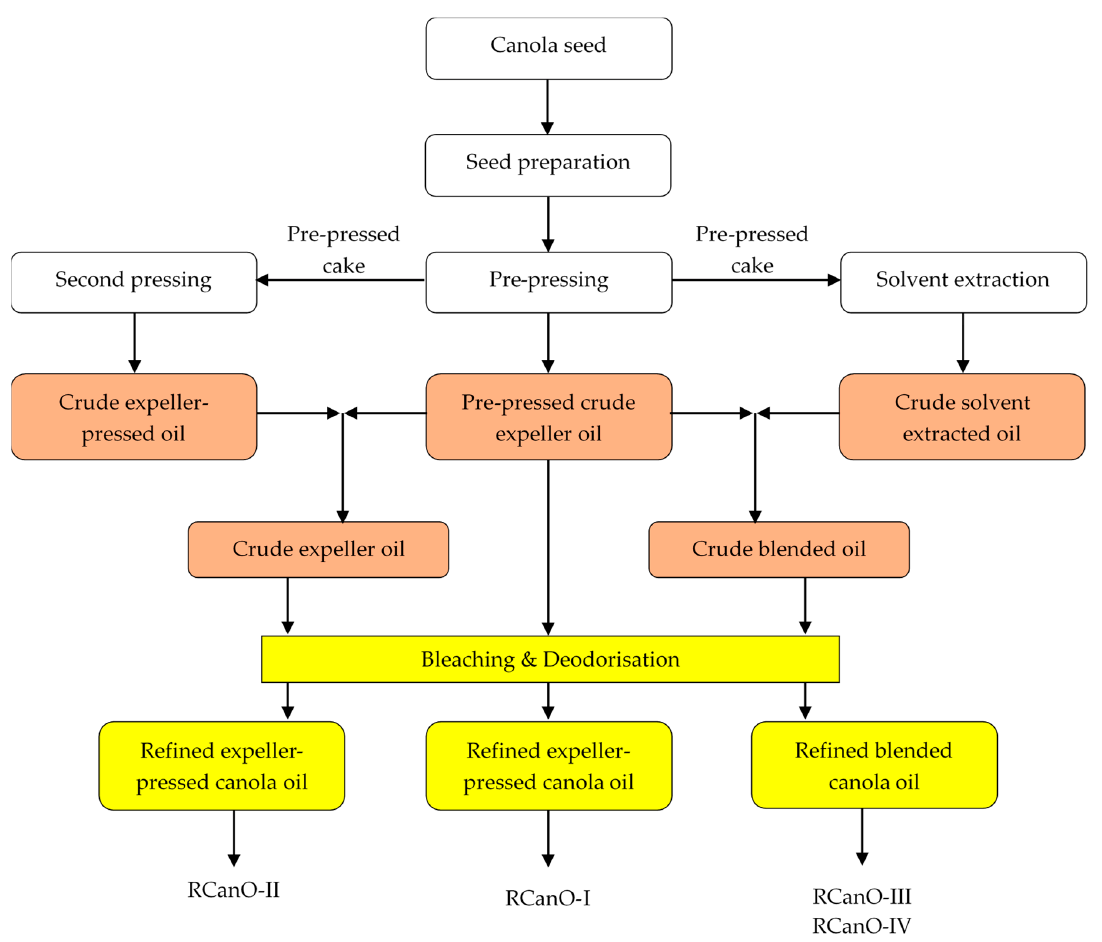
Figure 1. Flow chart showing main processing streams for the different canola oils.